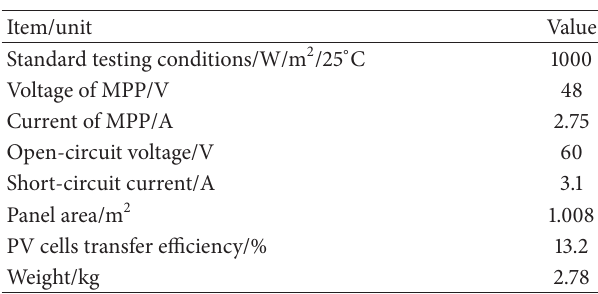
According to (1), (2), and (3), Table 1: Parameters of PV